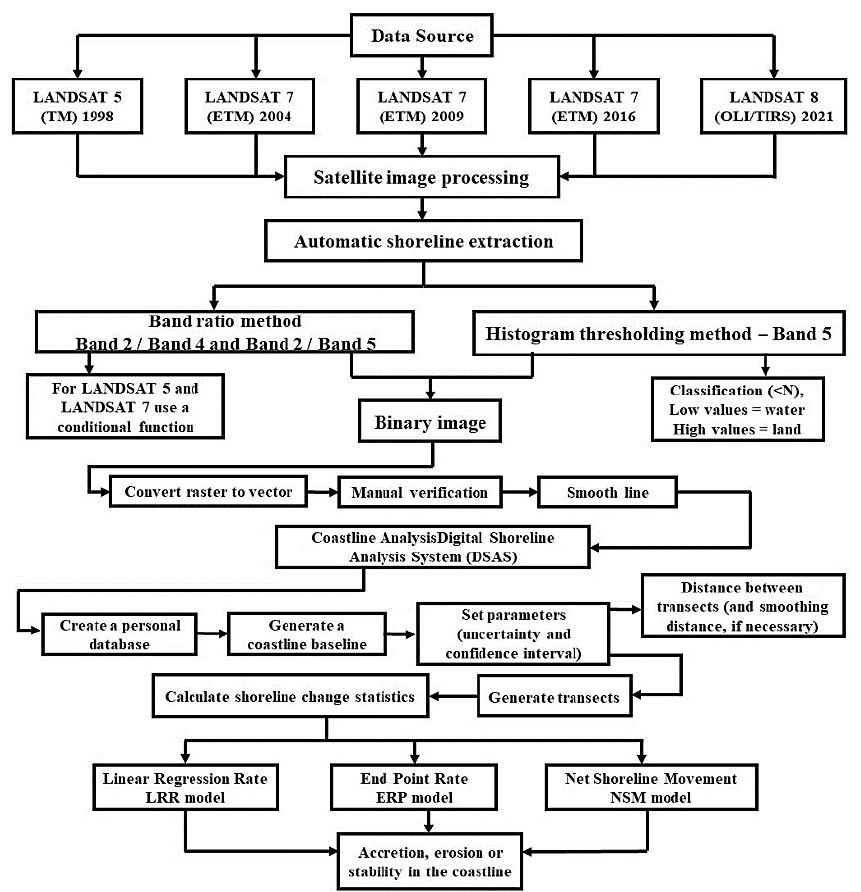
Figure 5. Applied methodology for the analysis of the evolution of the shoreline.